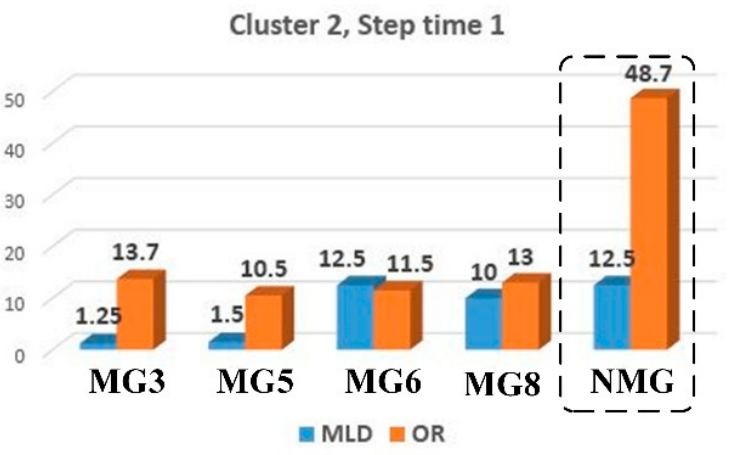
Figure 8. MLD and OR of MG3, MG5, MG6, and MG8 in individual and clustered operating mode.